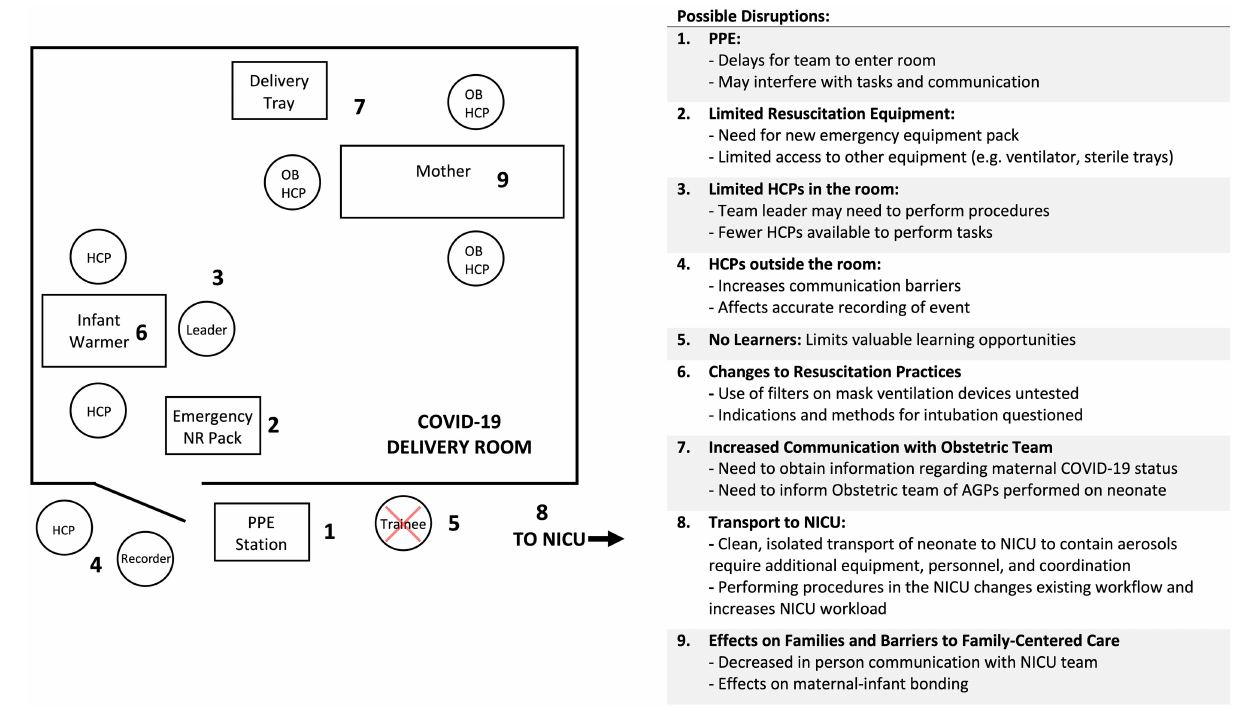
Frontiers in Pediatrics |